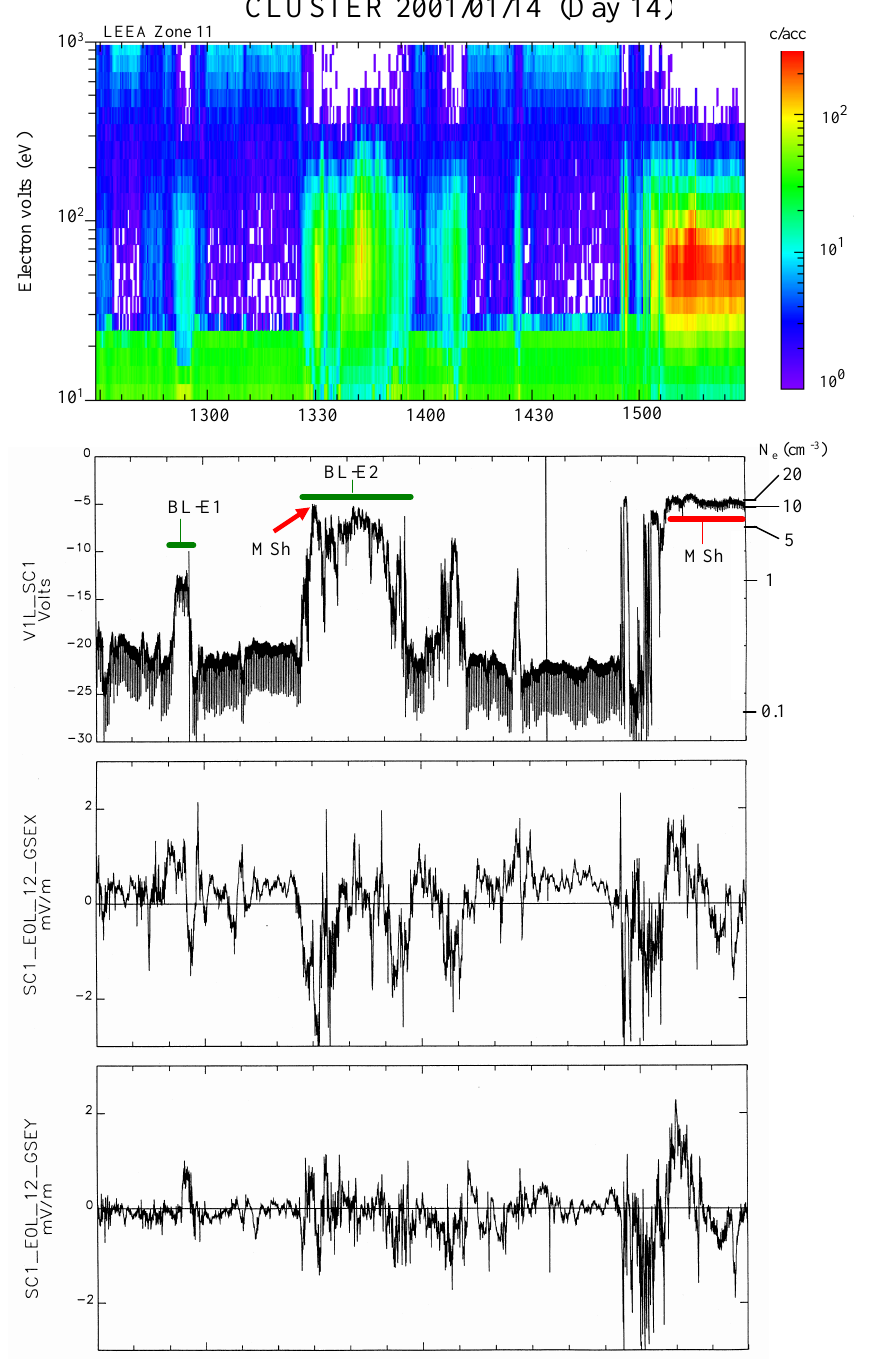
Fig. 3. The top panel shows the spec- trogram obtained by PEACE at space- craft 1 from 12:30–15:30UT. The accu- mulated counts in each energy bin (for LEEA) have been plotted as a function of time (colour bar on right side). The second panel from the top represents the negative of the spacecraft potential for spacecraft 1. The spacecraft poten- tial has been calibrated against electron density, and the electron density scale is given on the right. The two bottom pan- els show the GSE X and Y components of the electric field versus